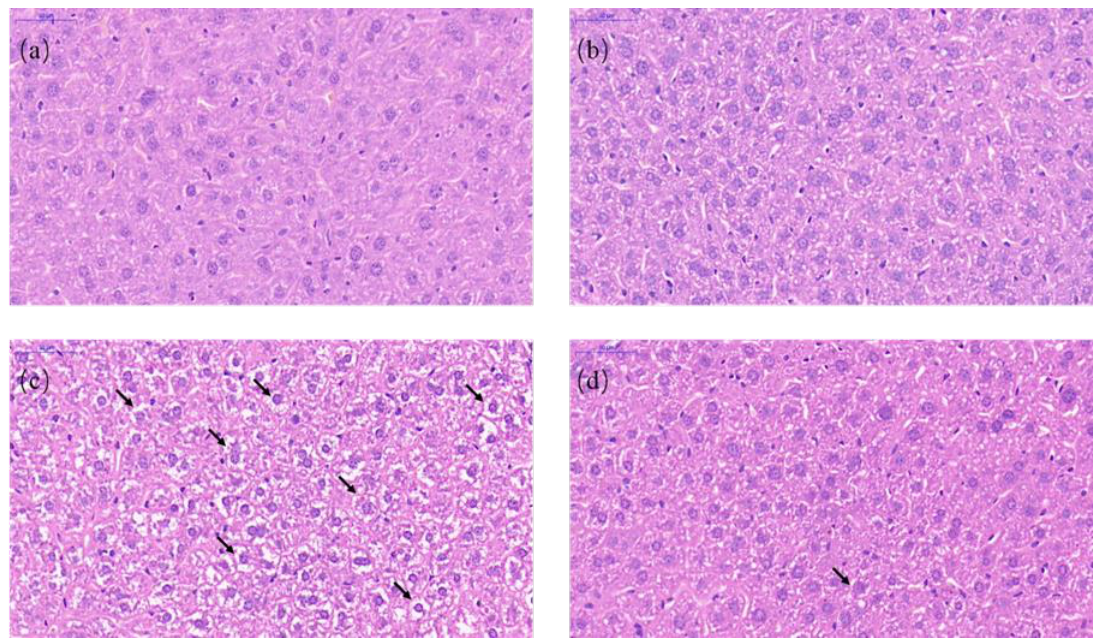
Figure 3. Light microscopy of liver tissues in different groups (40× magnification). ( a ) CON, ( b ) RESl., ( c ) AFB 1 , and ( d) ARE. Hematoxylin–eosin staining of liver section. Scale bars, 50 μm.